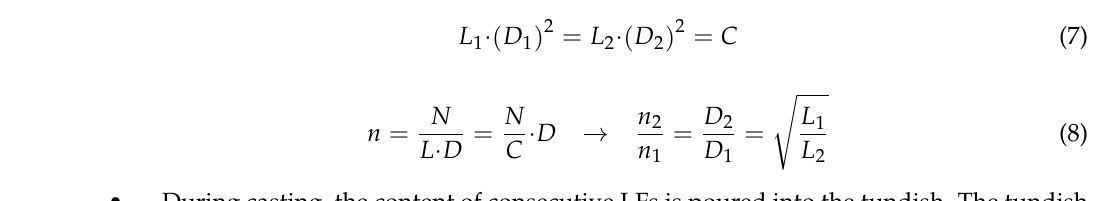
Figure 7. Sketch showing the modification in shape and distribution undergone by the NMIs as a consequence of the rolling process.